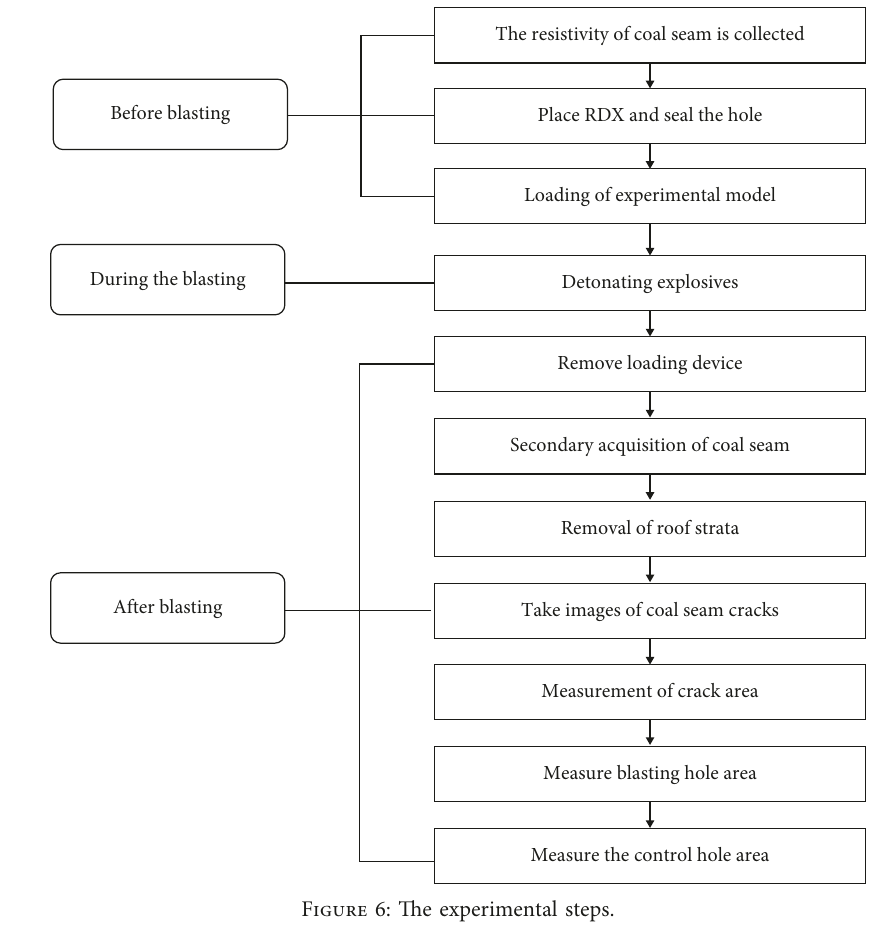
Figure 6: The experimental steps.